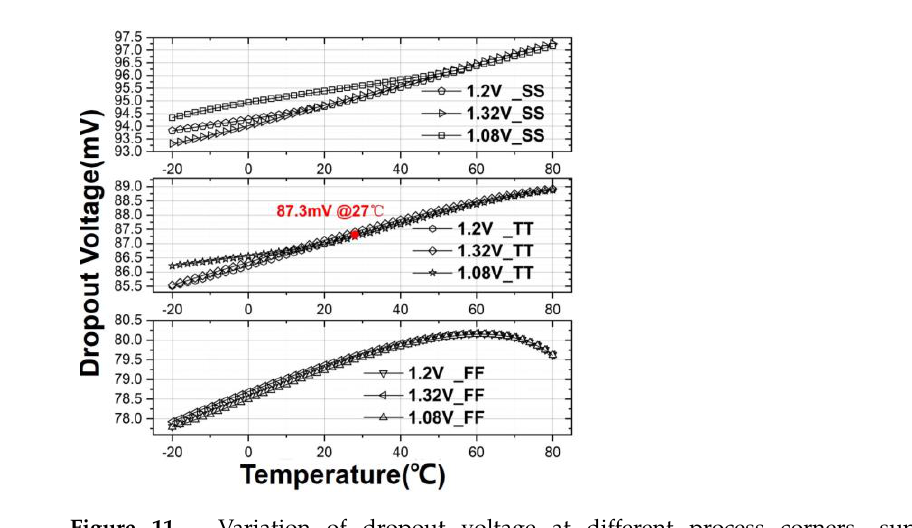
Figure 11. Variation of dropout voltage at different process corners, supply voltages and temperatures.